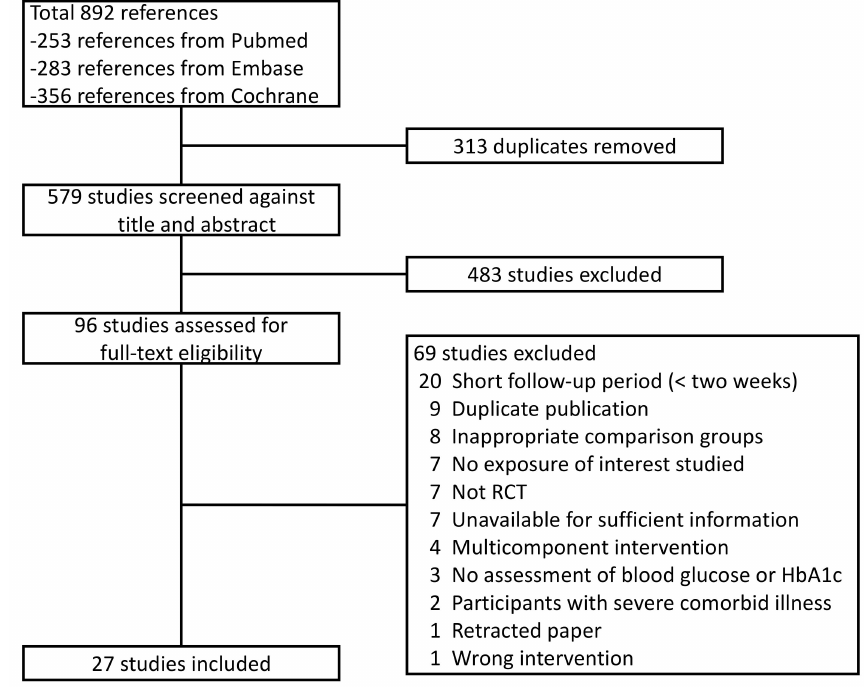
Figure 1. Study selection flow.